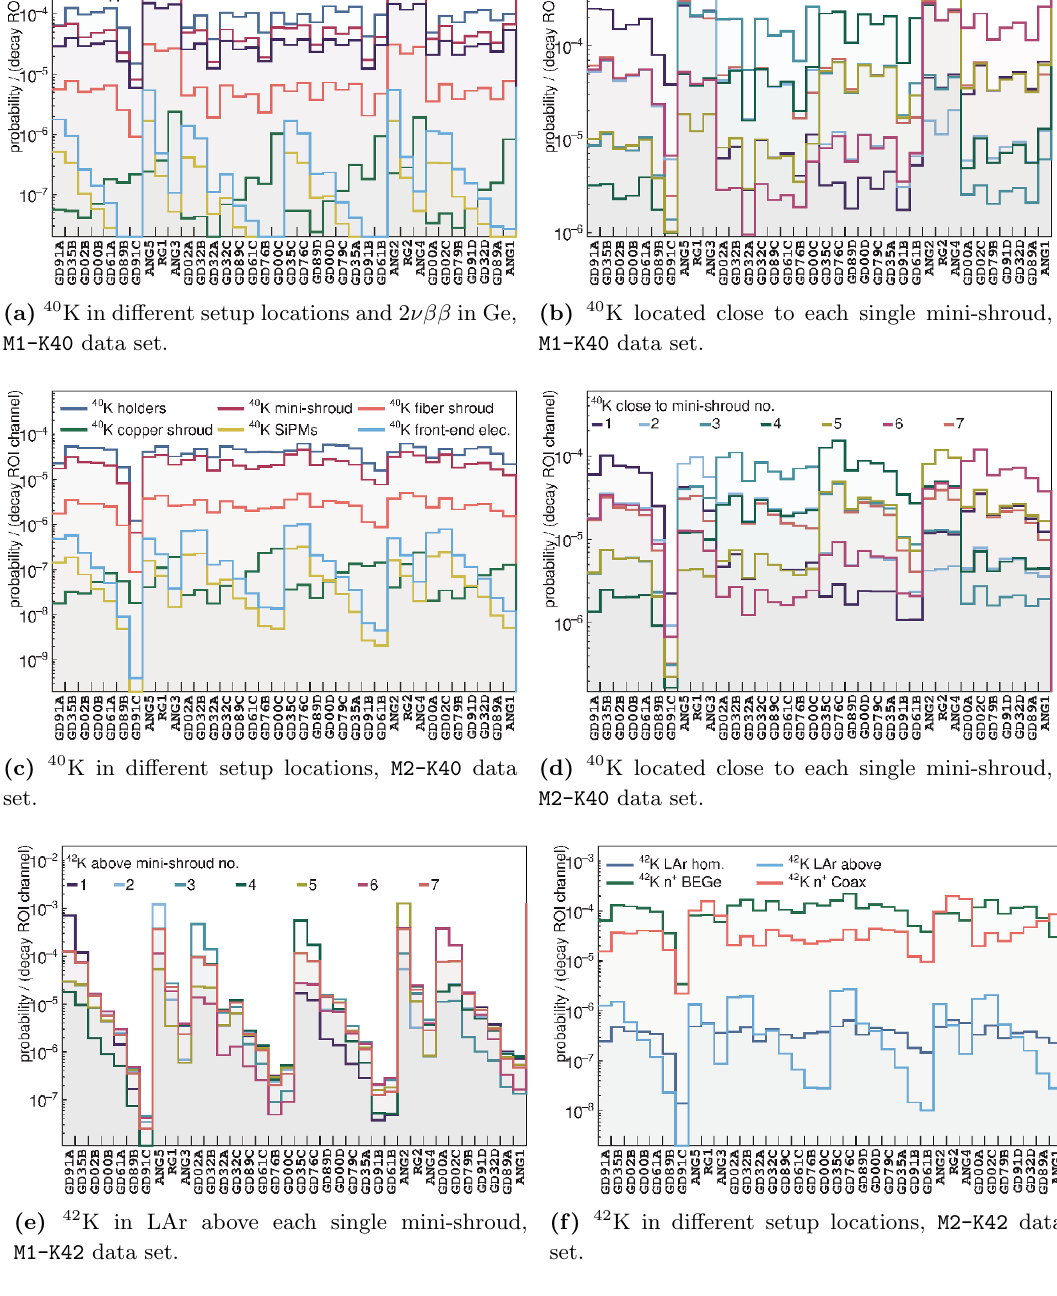
Figure 12. PDFs binned in detector space for the potassium tracking analysis. All PDFs are normalized to the number of simulated primary decays.